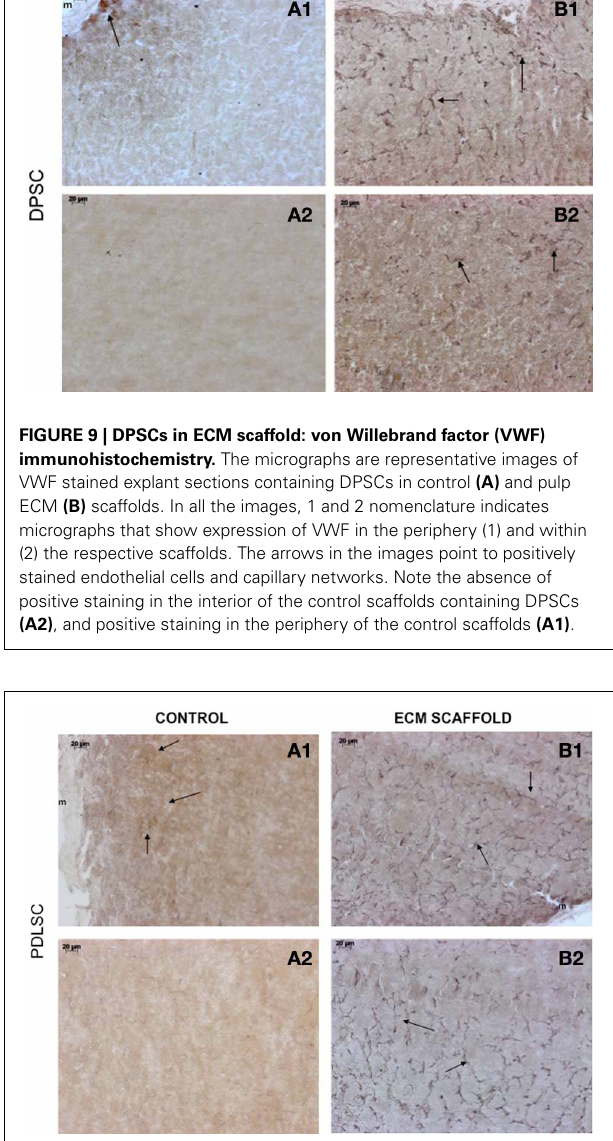
DSP, DPP, and DMP1 using DPSCs and biomimetic pulp